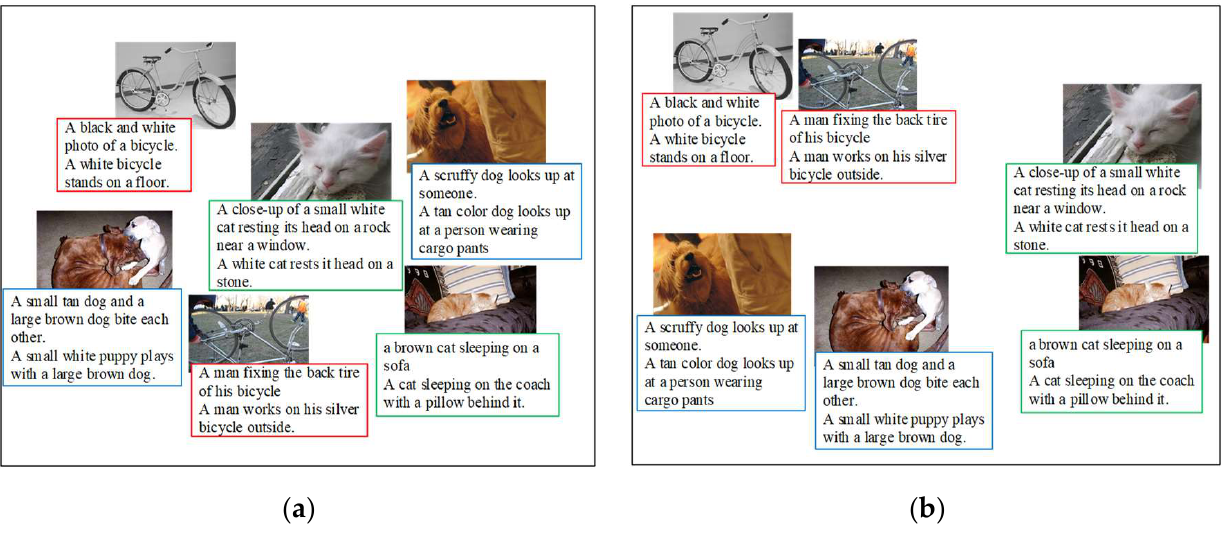
Figure 4. Similarity relationship preserving among samples. ( a ) The sample distribution with only inter-modal similarity preserving constraint. ( b ) The sample distribution with both inter- and intra-modal similarity preserving constraints.